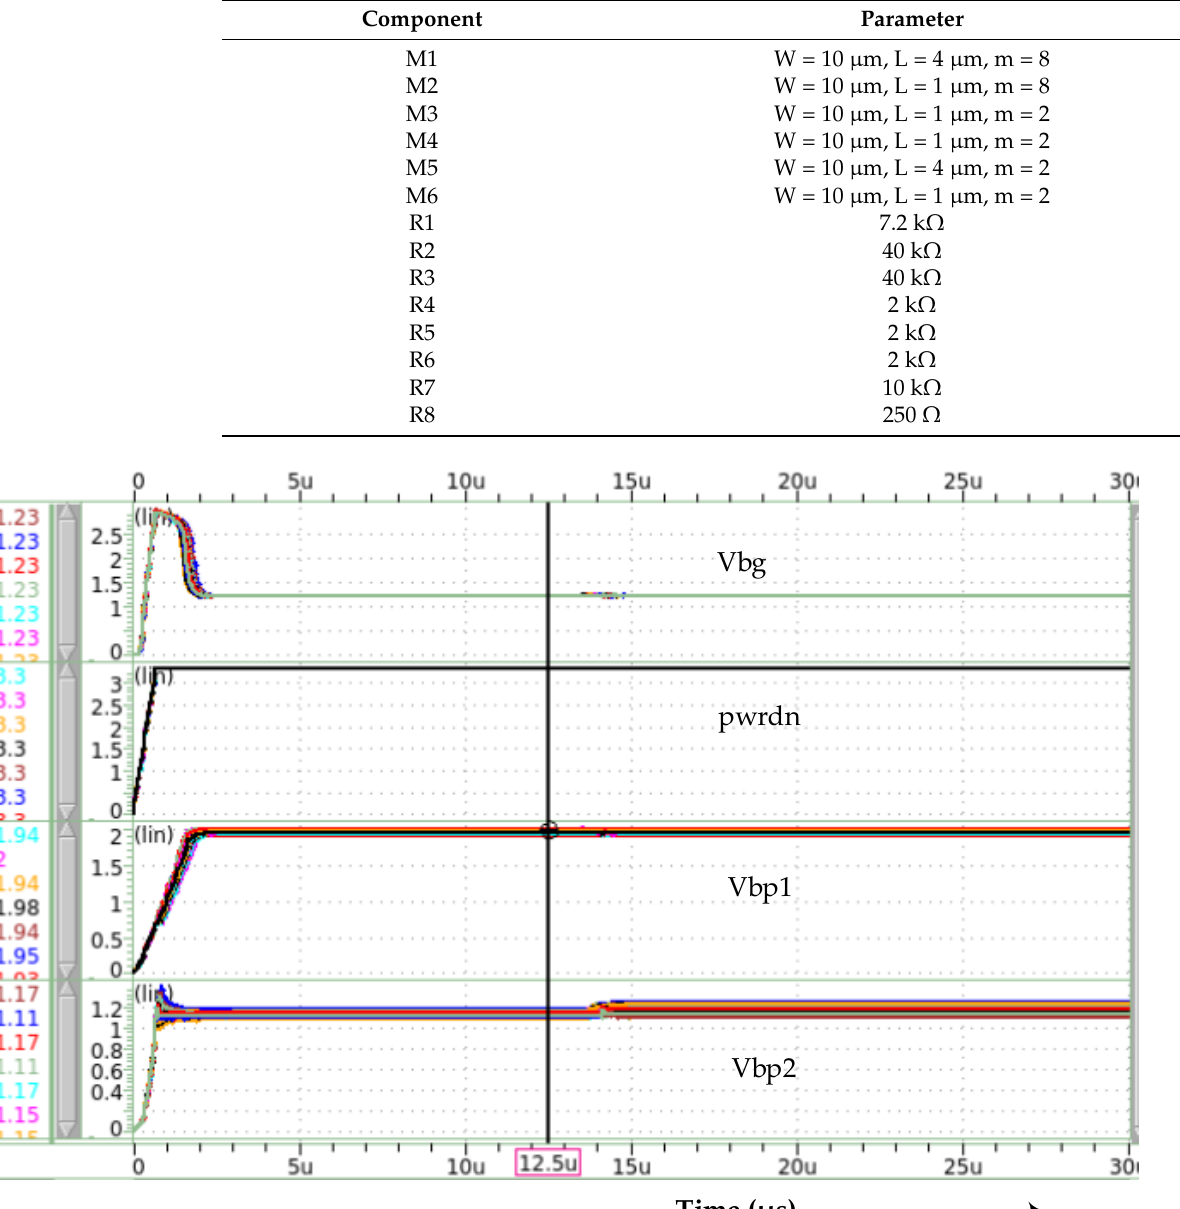
Table 1. Summary of component dimensions of the proposed BGR architecture.